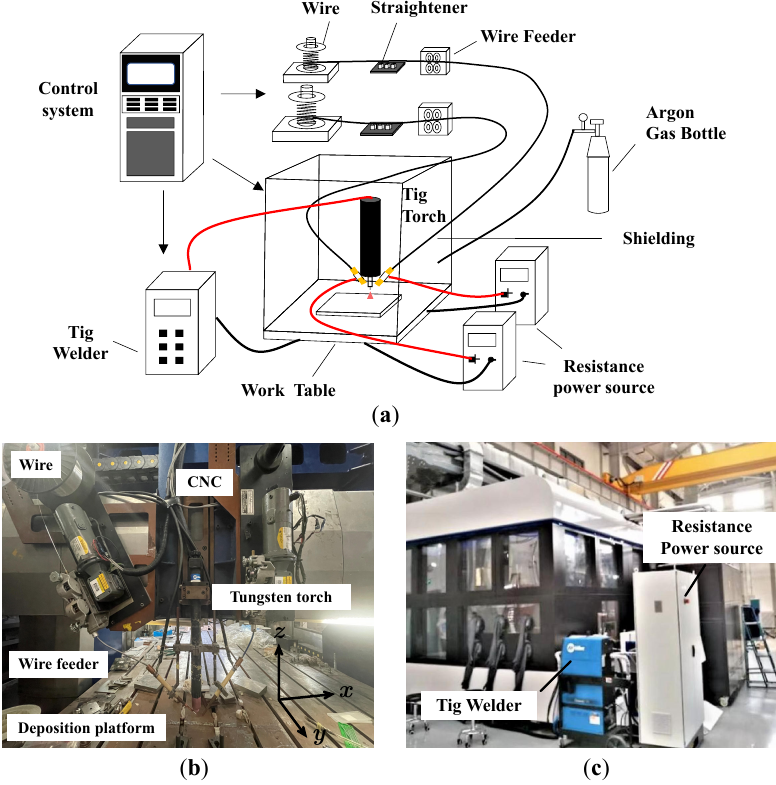
Figure A2. The WAAM equipment: ( a ) schematic diagram of WAAM equipment, ( b ) equipment details, ( c ) photo of the